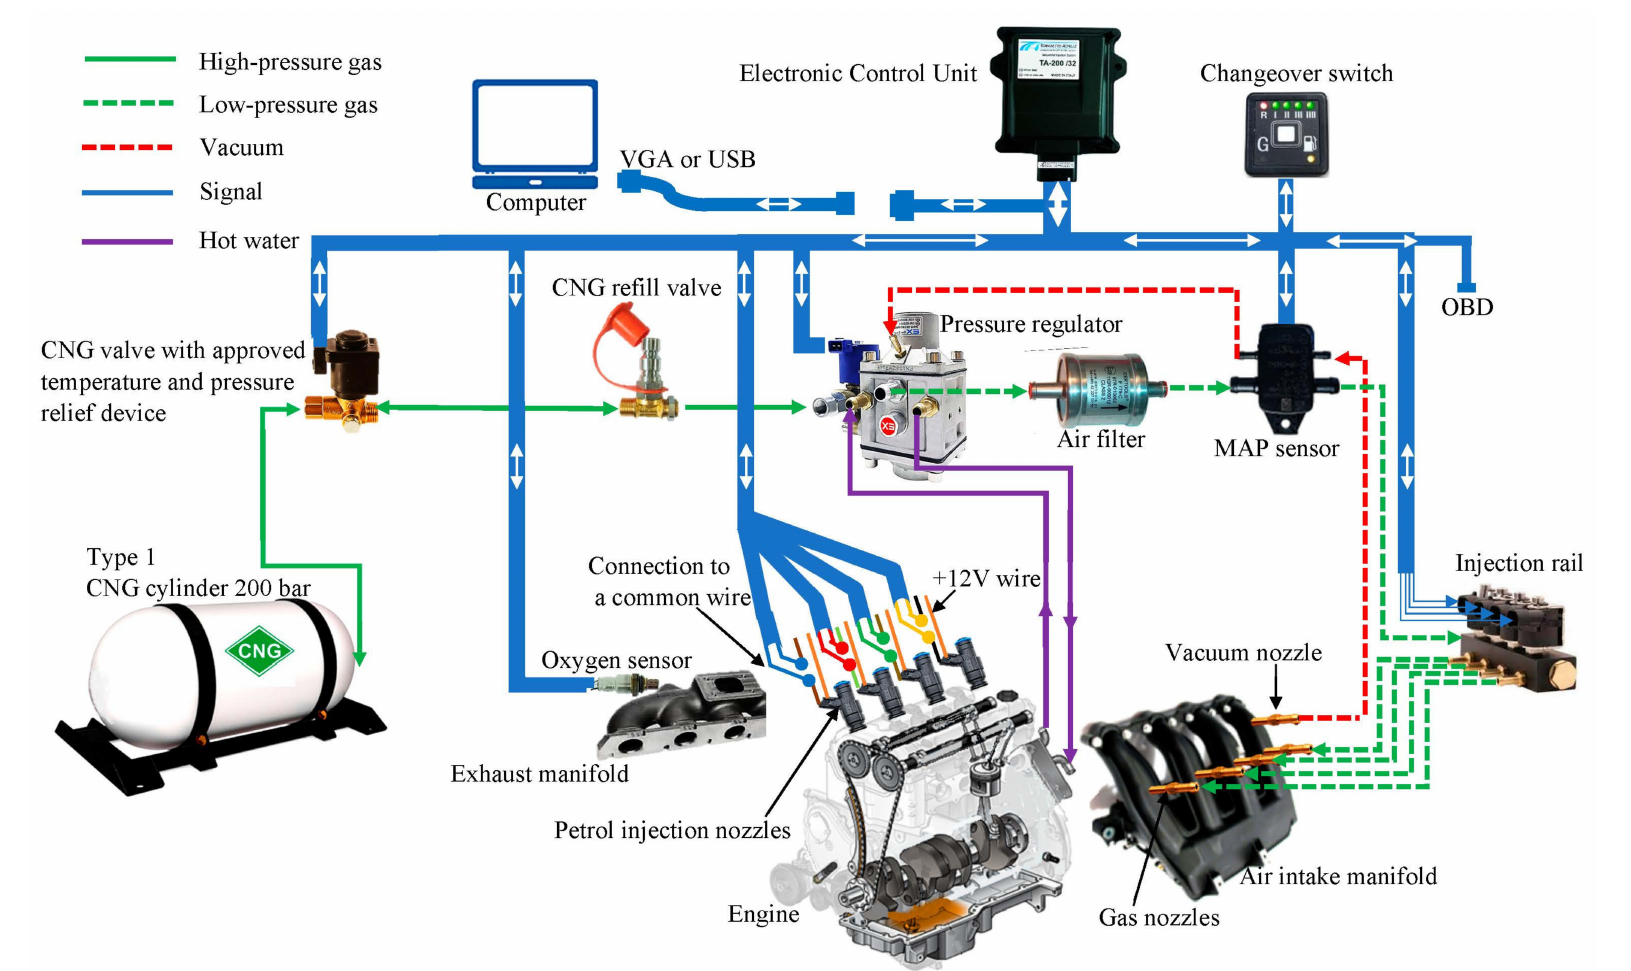
Figure 1. The arrangement of CNG components in petrol-fueled